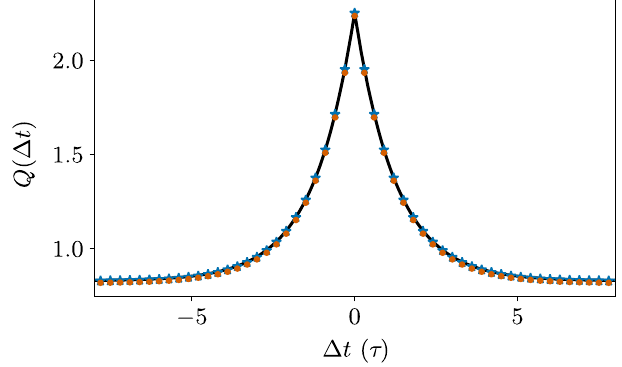
FIG. 5. Matched second-order statistics in binary and rate net- works. (a) Autocorrelation functions in simulations of binary (dark orange dots) and rate networks (blue stars). Theoretical curve (black)givenbythesolutionofEq.(10).Noiseamplitudeoftherate network chosen by Eq. (22) to obtain matched statistics. Other parameters: N ¼ 5000 , g ¼ 1 . 5 , ¯ g ¼ 0 , τ ¼ 1 ms, and T ð h Þ